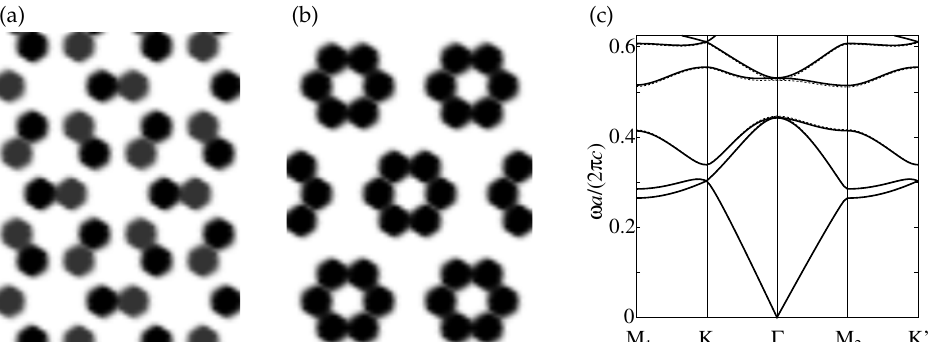
Figure 4. ( a ) A sample inversion asymmetric 2D quasi-topological photonic crystal for relative permittivity of 1, 9, and 11 in white, dark gray, and black regions, respectively. When the inversion symmetry is restored, the crystal can be in the topological phase. ( b ) A sample 2D photonic crystal in non-topological phase for relative permittivity of 1 and 10 in white and black regions, respectively. ( c ) Band diagram of TM modes of the photonic crystal in ( a ); dotted lines show the case where the relative permittivities of the gray and black rods are set to 10. The vertical axis represents the dimensionless frequency ω a / ( 2 π c ) . ( a : lattice constant and c : speed of light).